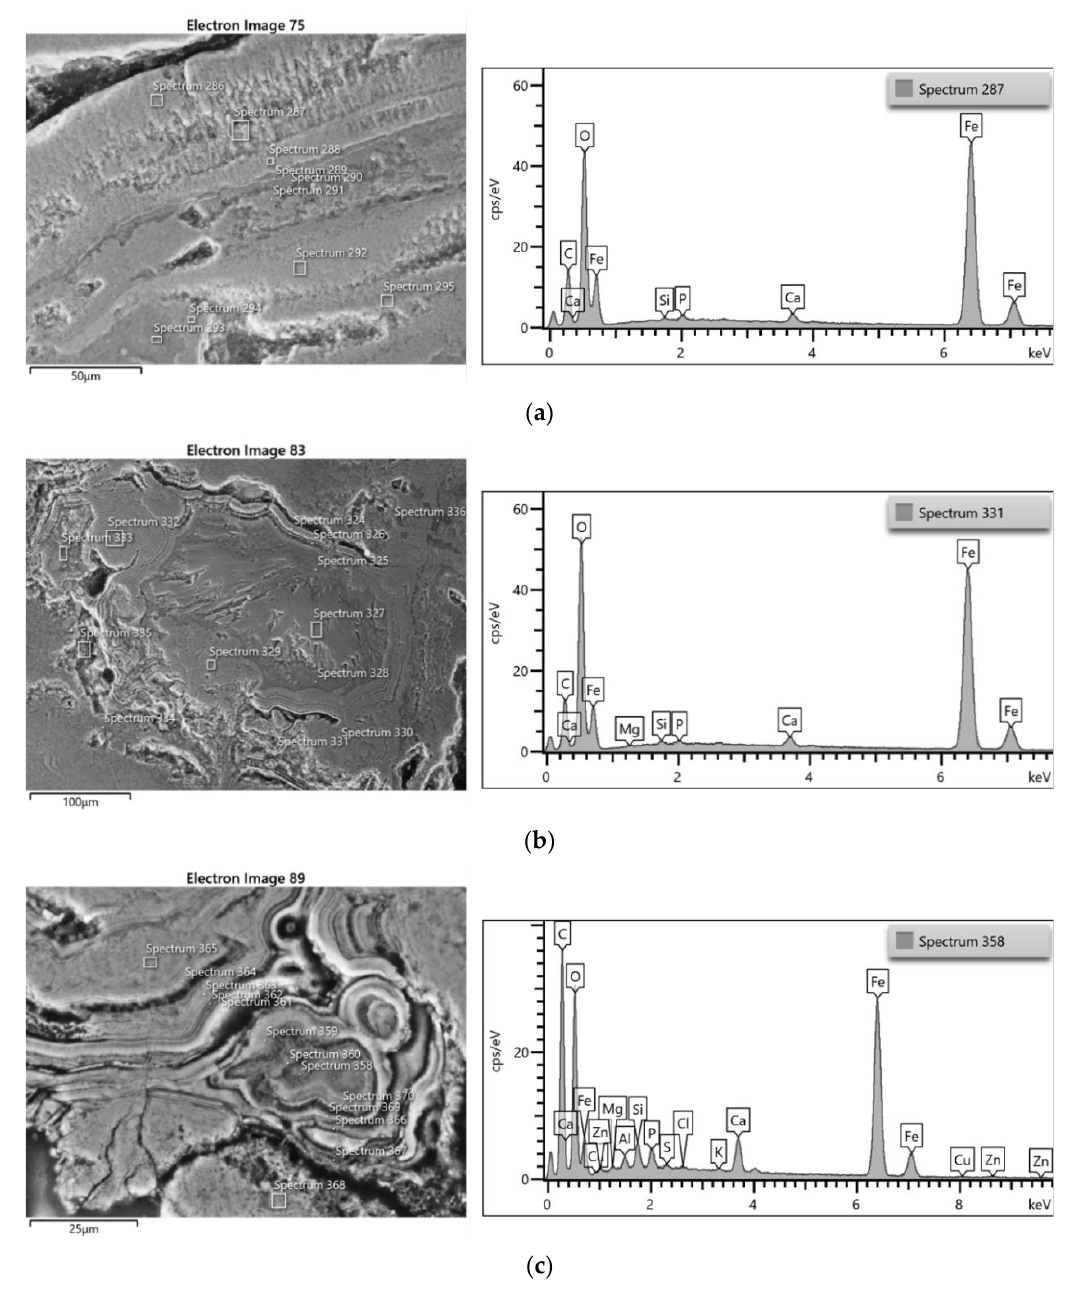
and Zn oxides. In all the spectra, Mg, Al, Si, P, S, Cl, K and Ca oxides occurred in very low values. Na, Sn and Pb oxides were not detected.